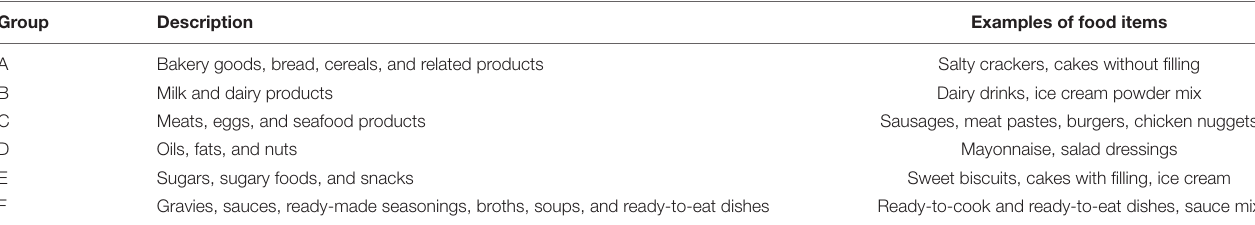
TABLE 1 | Description of packaged food labels sampled in 2010 and 2013, stratified by food groups according to the Brazilian and Mercosur regulation on nutrition labeling (36).